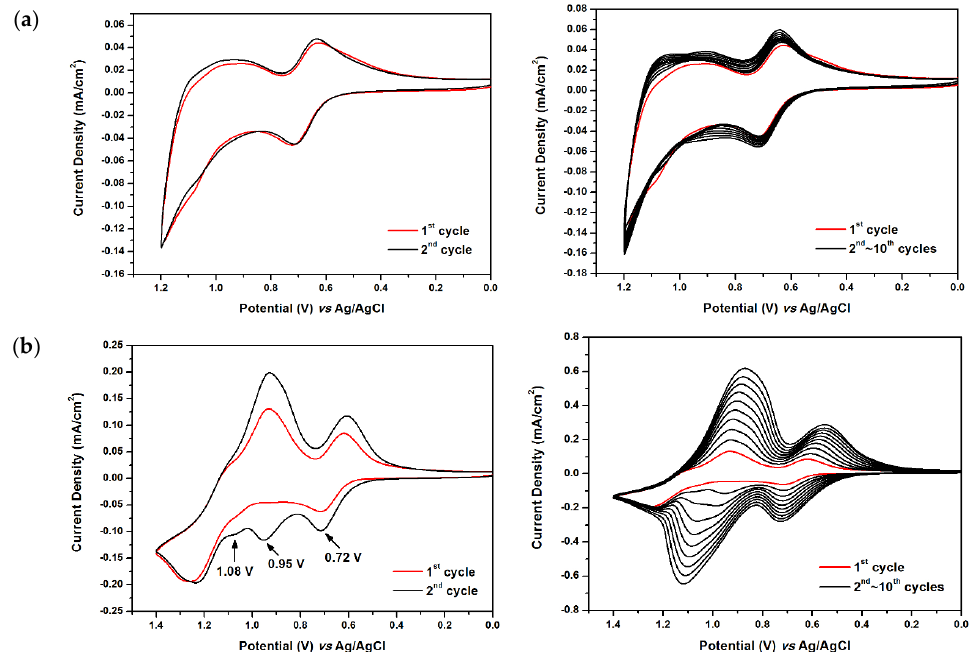
Figure 5. Repetitive cyclic voltammograms of 2 × 10 − 4 M MeOTPA-(TPA) 2 in 0.1 M Bu 4 NClO 4 /CH 2 Cl 2 solution in the potential range of ( a ) 0–1.2 V and ( b ) 0–1.4 V at a scan rate of 50 mV · s − 1 . Polymers 2017 , 9 , 708